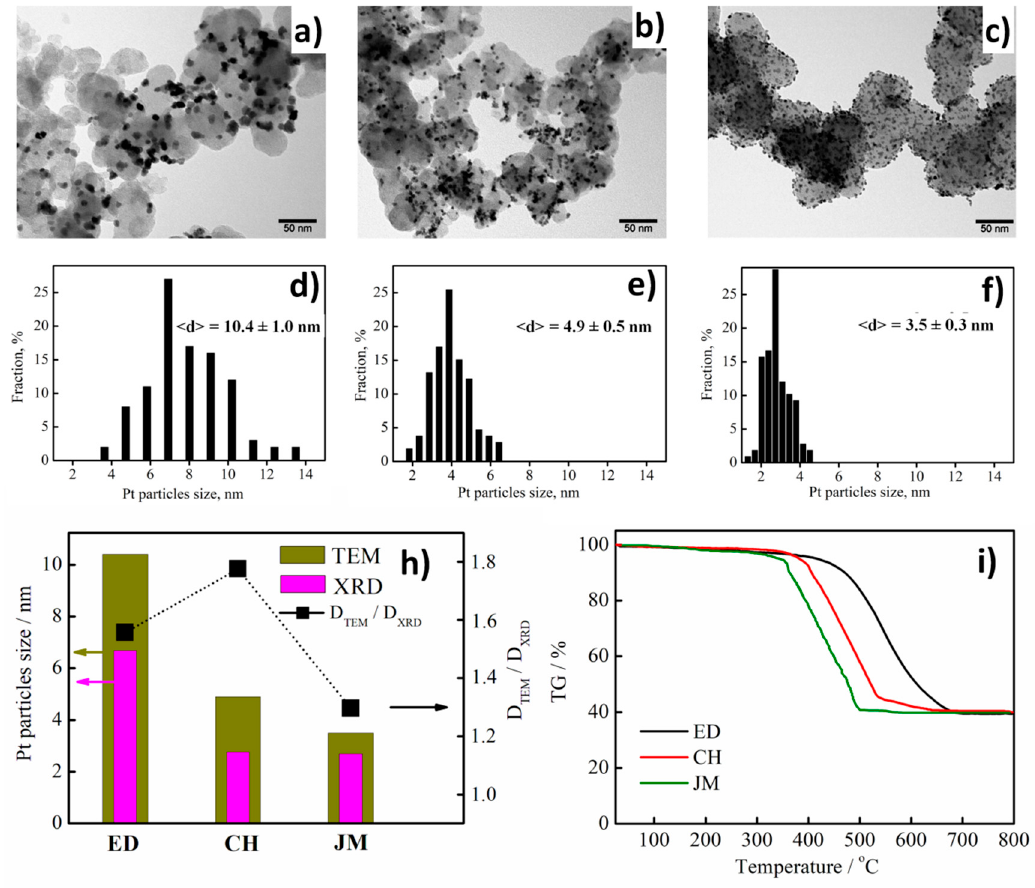
Figure 2. ( a )–( c ) Transmission electron microscopy images and ( d )–( f ) platinum particle size distributions in the Pt / C electrocatalysts: ED ( a , d ), CH ( b , e ), and JM ( c , f ) samples; a comparison of Pt particle sizes (D 111 ) evaluated via XRD and TEM ( h ); TGA of the ED, CH, and JM samples ( i ).